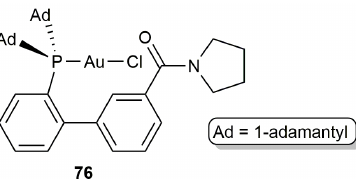
Figure 8. Structure of the gold(I)-biphenylphosphine complex 76 .